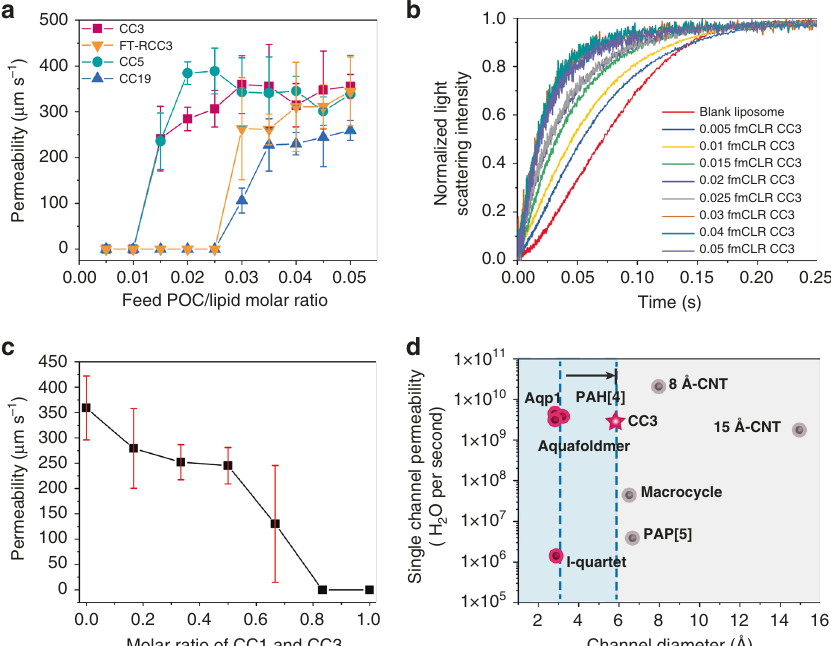
Fig. 2 Water permeability of liposomes embedded with POCs. a Permeabilities of POCs (CC3, FT-RCC3, CC5, and CC19) with loadings from 0 to 0.05 fmCLR measured under hypertonic conditions at 25 °C. b Representative stopped- fl ow traces from tests performed on liposomes embedded with CC3 of various fmCLRs. c Water permeabilities of liposomes with a combined fmCLR of 0.03 for CC1/CC3 mixture. Molar ratio of 0.0 refers to fmCLR of 0.03 for CC3 (no addition of CC1), and molar ratio of 1.0 refers to fmCLR of 0.03 for CC1 (no addition of CC3). d Single-channel water permeabilities of CC3 (this study) and synthetic channels with reported stopped- fl ow values 4,8 – 13 . Pink color indicates channels with total ion rejection while gray color indicates channels with partial to no cation rejection. Notably, the CC3 water channel can push the limit of ion-rejecting channel diameter from 2.8 to 5.8 Å, as indicated by the arrow. Error bars represent standard deviations of three independent